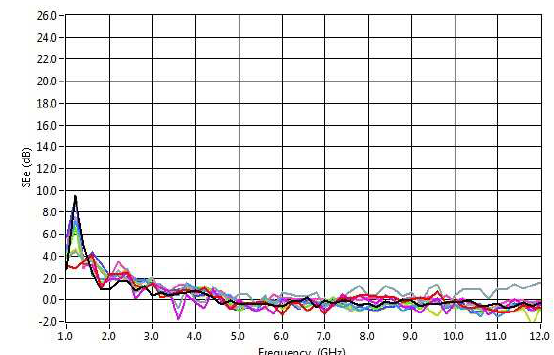
Figure 13: Corrected SE e from measurements of 5 mm mesh size enclosure; 10 independent measurement